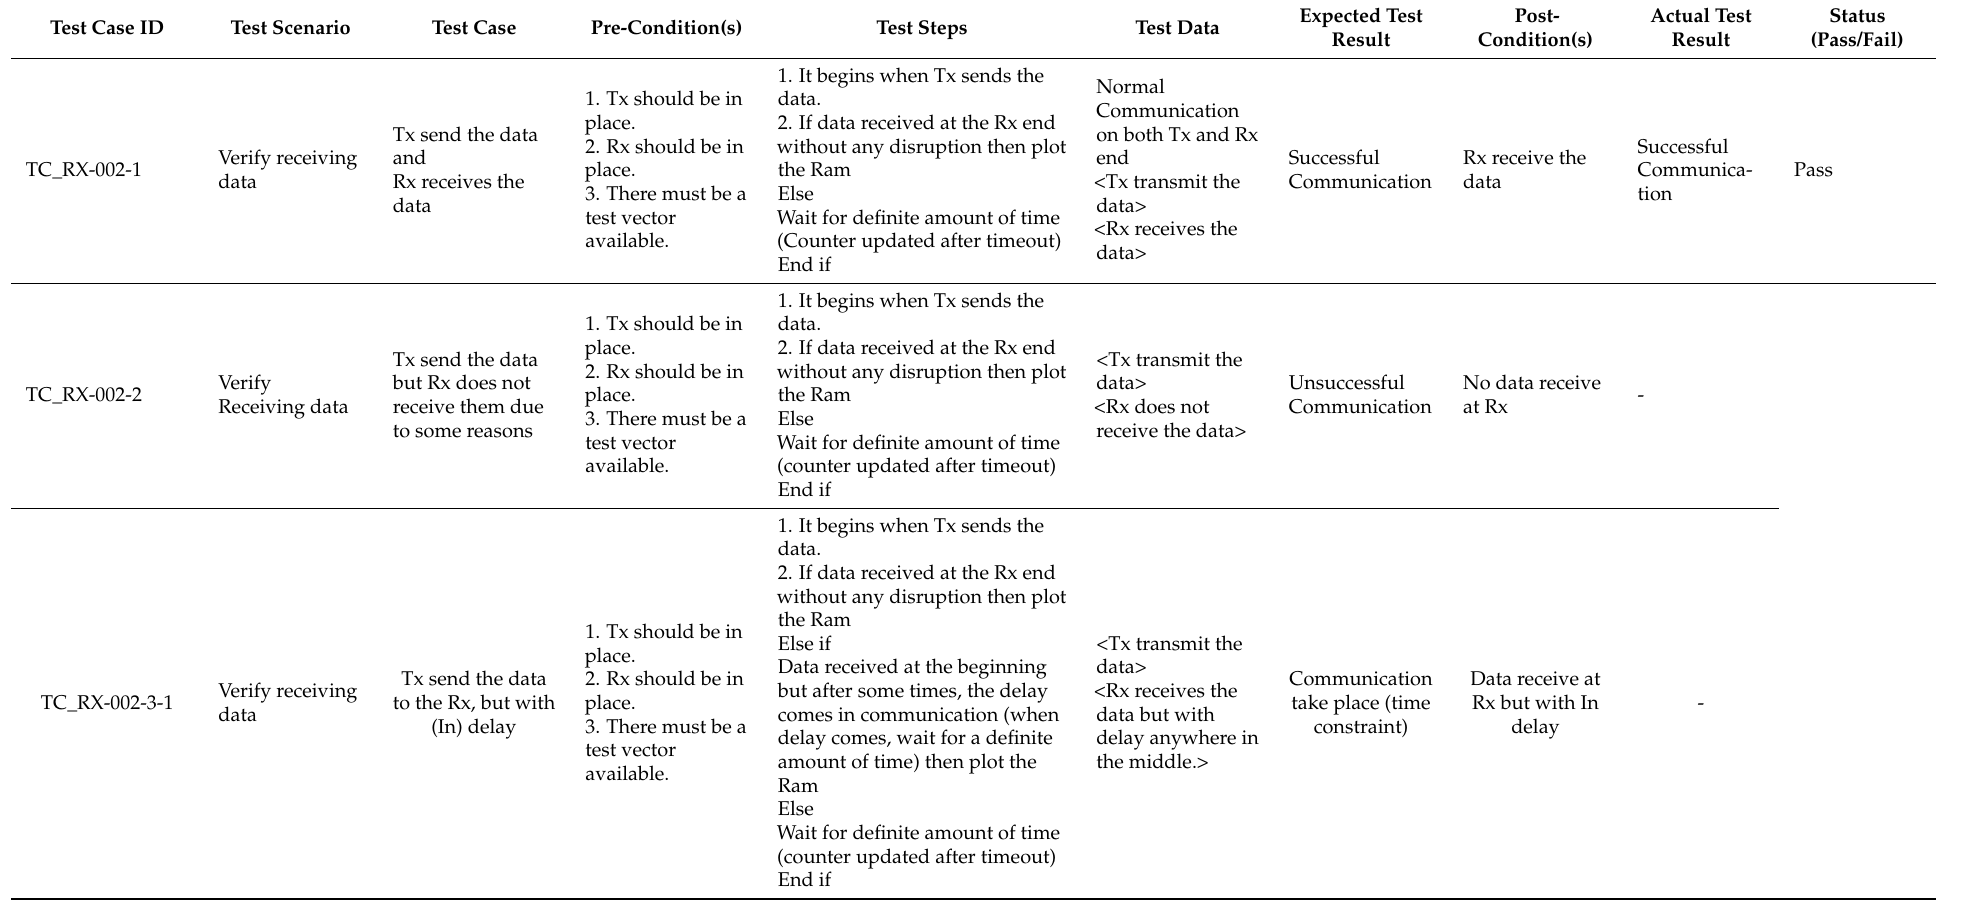
Table A1. Test cases for